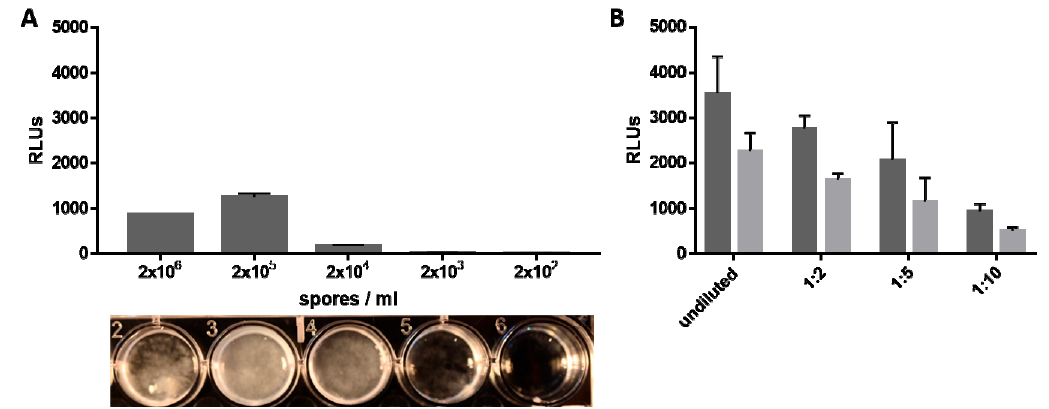
Figure 2. ( A ) Light emission in dependency of inoculum density. YNB medium was inoculated with different concentrations of R7B_luc spores, light emission was induced by addition of luciferin after 24 h and detected by plate reader (upper panel). Relative light units (RLUs) represent the average of three independent measurements. Error bars indicate standard deviation. The lower panel shows fungal growth at the various spore concentrations after 24 h of incubation. ( B ) Light emission in dependency of substrate concentration. 2 × 10 5 spores/mL were inoculated in YNB and light emission was induced by addition of different concentrations (undiluted, 1:2, 1:5; 1:10) of luciferin dissolved according to the manufacturer´s protocol (Roche, Basel, Switzerland). Light was detected immediately (dark grey bars) and 10 min after substrate addition (light grey bars). Error bars indicate standard deviation.